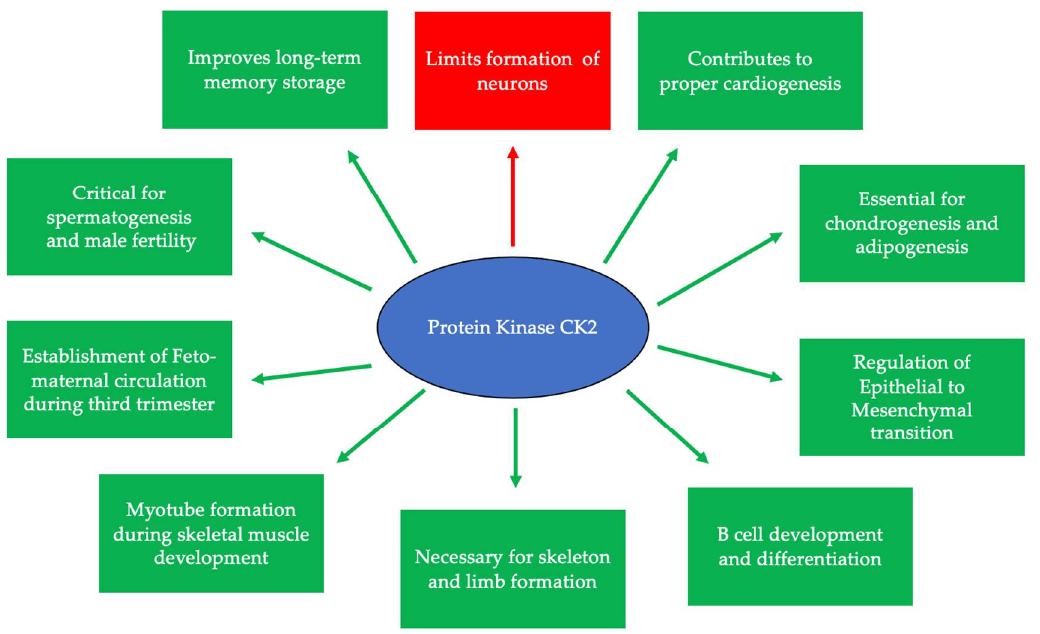
Figure 1. CK2 is expressed at embryonic day 11 and is critical for many developmental processes. Specifically, CK2 is necessary for limiting neurogenesis and preventing the excessive differentiation of neurons. In addition, CK2 expression promotes long-term memory storage. Further, this protein is essential for skeletogenesis, chondrogenesis, adipogenesis, and proper limb formation. CK2 contributes to spermatogenesis, and the inhibition of its expression leads to infertility. Finally, CK2 is important for B cell differentiation and development, myotube formation, the regulation of the epithelial-to-mesenchymal transition (EMT), and the establishment of circulation between the fetus and the mother during the third